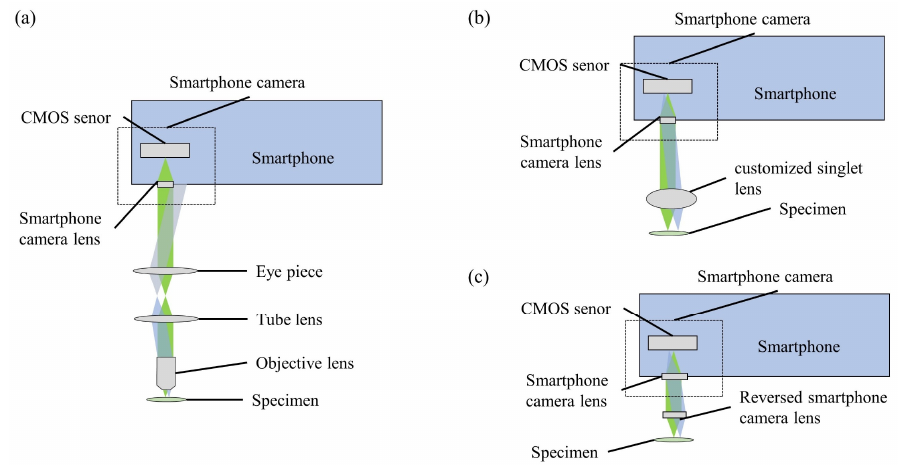
Figure 7. Smartphone platforms based on: ( a ) commercial microscopic objective lenses, ( b ) custom- ized single lenses, ( c ) inverted pinhole lenses.